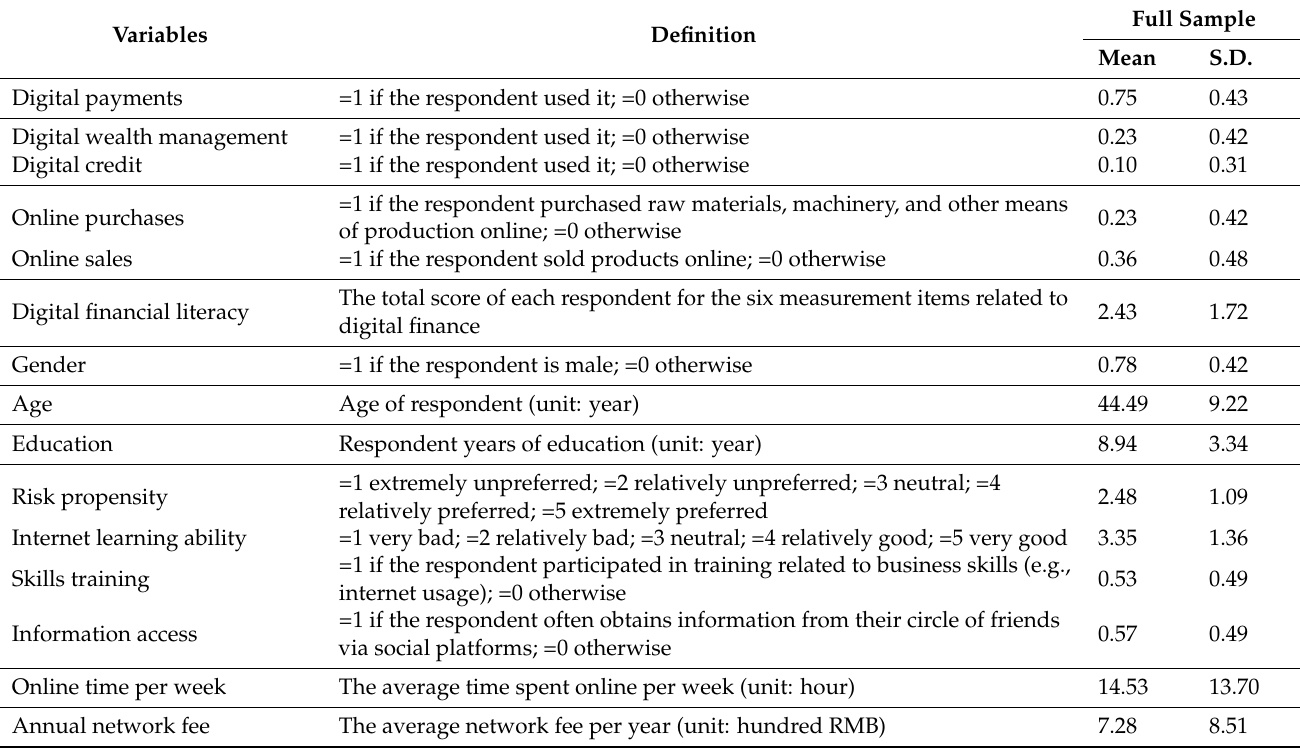
Table 1. Definition and summary of